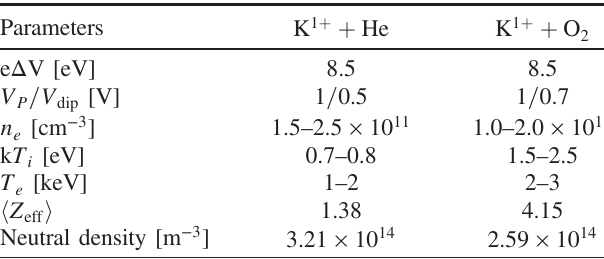
TABLE VII. Final optimum parameters used in the simulations to reproduce the K 1 þ and K 2 þ Δ V curves.